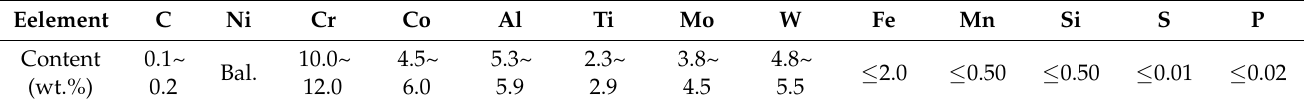
Figure 1. Schematic diagram of the sample fabrication steps. Table 1. Chemical composition of the K3 nickel-based superalloy.